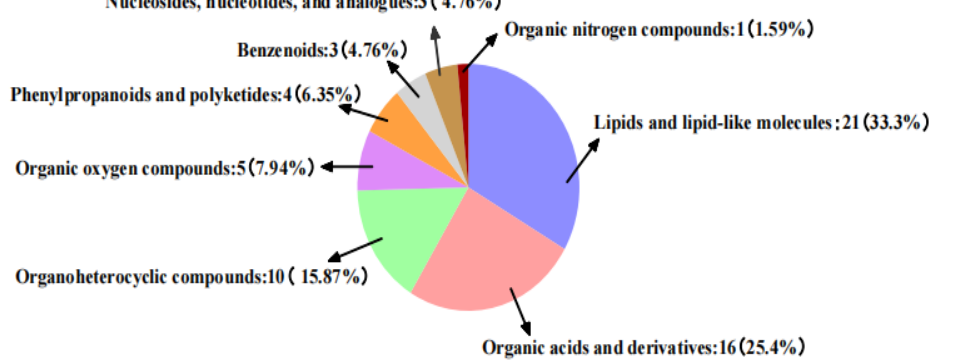
Figure 5. Classification of HMDB compounds with differential metabolites in the Z-2-GS-2 vs. GS groups.